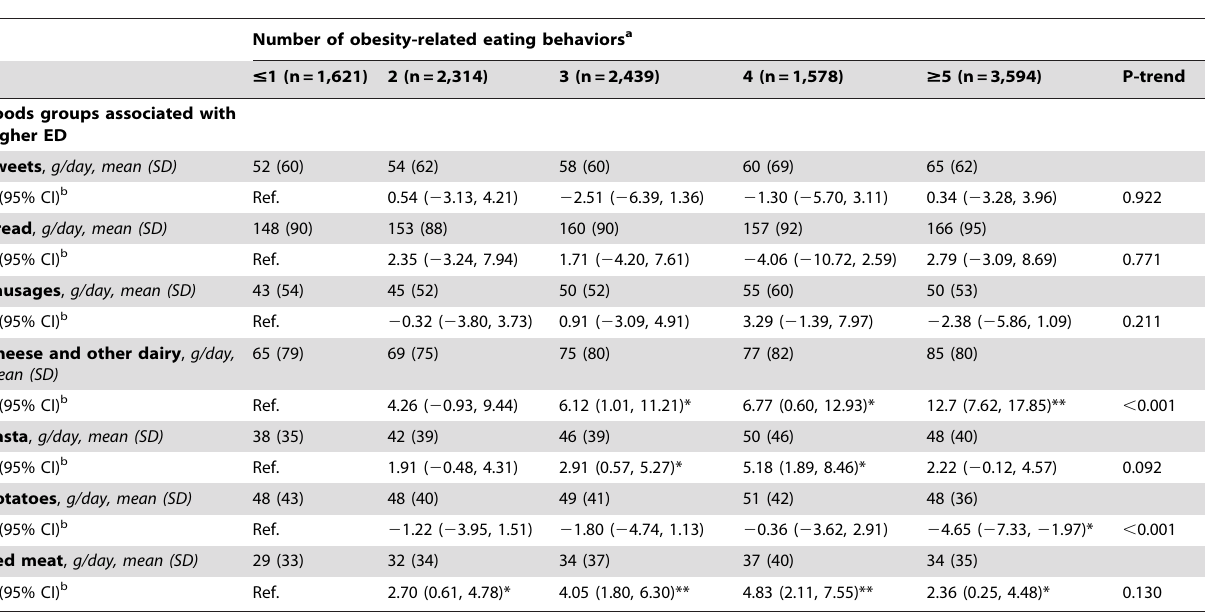
Table 6. Association of the number of obesity-related eating behaviors with individual foods groups associated with higher energy density (ED).